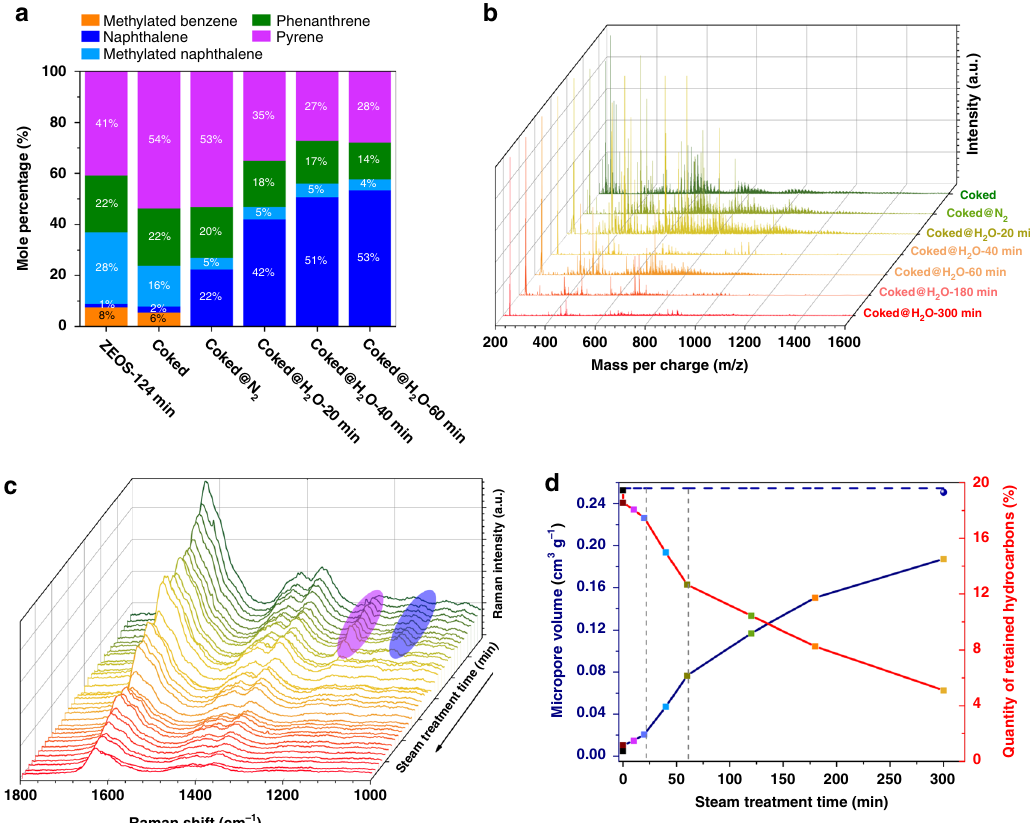
Fig. 4 Evolution of carbonaceous species and textual property of ZEOS-Coked samples. a Evolution of detailed distribution of carbonaceous intermediates with molecular mass smaller than 200 Da during nitrogen and steam cracking at 953 K, which is analyzed by GC-MS. b Evolution of carbonaceous species with molecular mass larger than 200 Da during nitrogen and steam cracking at 953 K, which is analyzed by MALDI FT-ICR MS. c Operando UV-Raman spectra of ZEOS-Coked samples treated by steam at 923 K with different time. d Evolution of textual property and coke quantity of ZEOS-Coked samples during steam cracking at 953